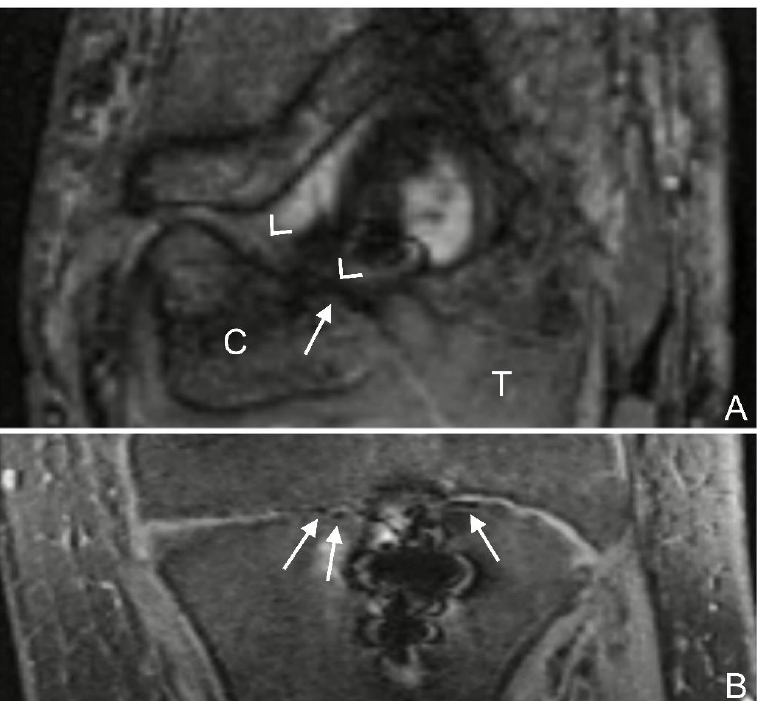
Figure 1. ( A ): T2 trufi 3d we (true fast imaging with steady-state free precession three-dimensional water excitation) coronal image of the left elbow of a 17-year-old boy with a lateral humeral condyle fracture. Gas locules within the growth plate of the humeral capitellum are seen as signal voids (arrow). The humeral capitellum ossification center (C), growth plate (arrow heads), and cartilaginous trochlea (T). ( B ): T2 trufi 3d we coronal image of the tibia of a 12-year-old boy with a tibial tuberosity fracture showing hypointense gas locules (arrows) within the tibial growth plate. Osteolysis : Similar to previously published studies with titanium screws, a well-de- fined, hyperintense, linear signal in fluid-sensitive sequences directly adjacent to the screw shaft was interpreted as fluid collection/osteolysis [29]. Its maximum short-axis width was measured (Figure 2).